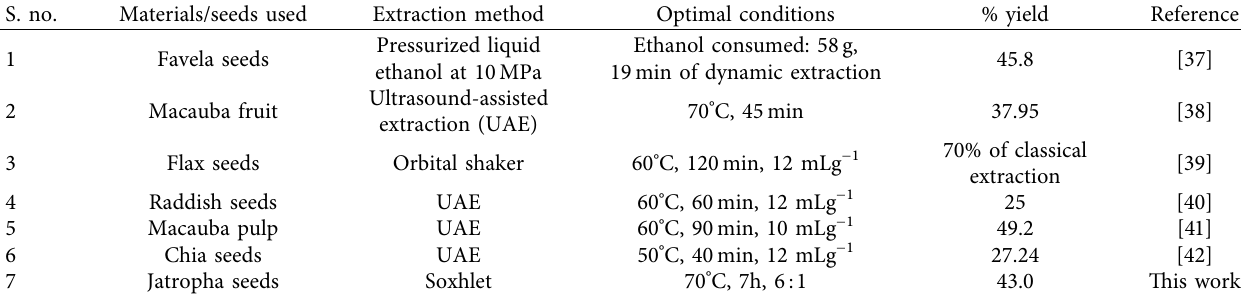
Table 3: Comparison of oil yield obtained using ethanol extraction from various materials. S.